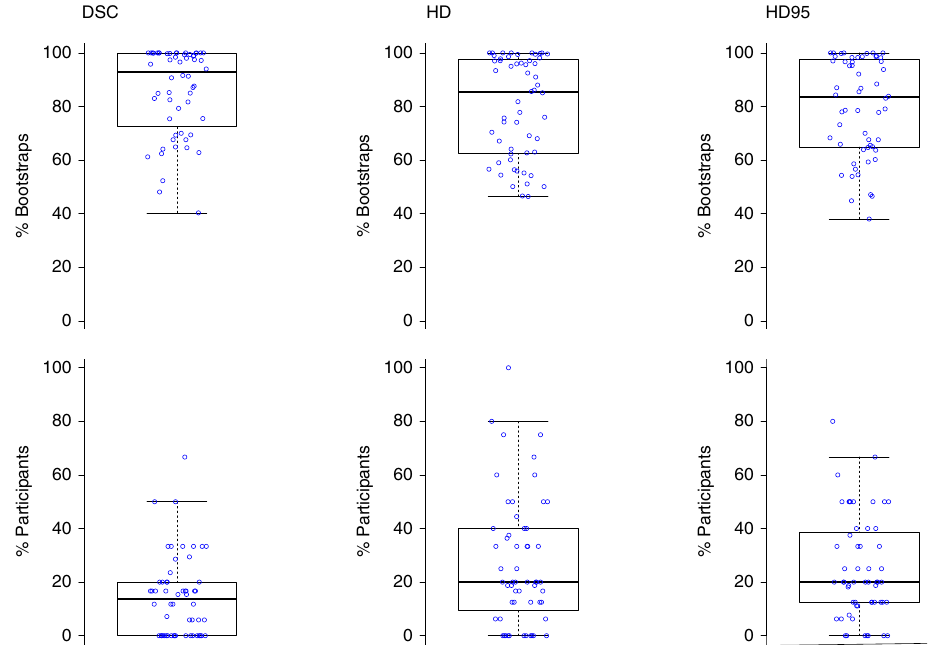
Fig. 4 Robustness of rankings with respect to the data used. Robustness of rankings with respect to the data used when a single-metric ranking scheme based on whether the Dice Similarity Coef fi cient (DSC) (left), the Hausdorff Distance (HD) (middle) or the 95% variant of the HD (right) is applied. One data point corresponds to one segmentation task organized in 2015 ( n = 56). The center line in the boxplots shows the median, the lower, and upper border of the box represent the fi rst and third quartile. The whiskers extend to the lowest value still within 1.5 interquartile range (IQR) of the fi rst quartile, and the highest value still within 1.5 IQR of the third quartile. Metric-based aggregation with mean was performed in all experiments. Top: percentage of simulations in bootstrapping experiments in which the winner (according to the respective metric) remains the winner. Bottom: percentage of other participating teams that were ranked fi rst in the